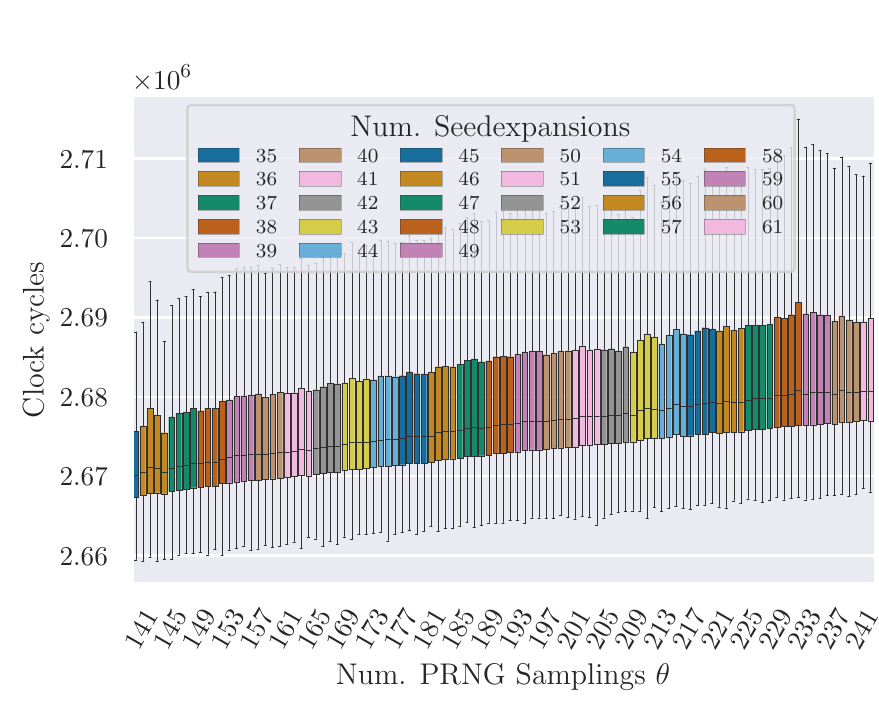
Figure 6: Box plots of 10 6 timing measurements of BIKE-L1 Decaps per value of θ . Values of θ with too few available plaintexts ( < 10) are not